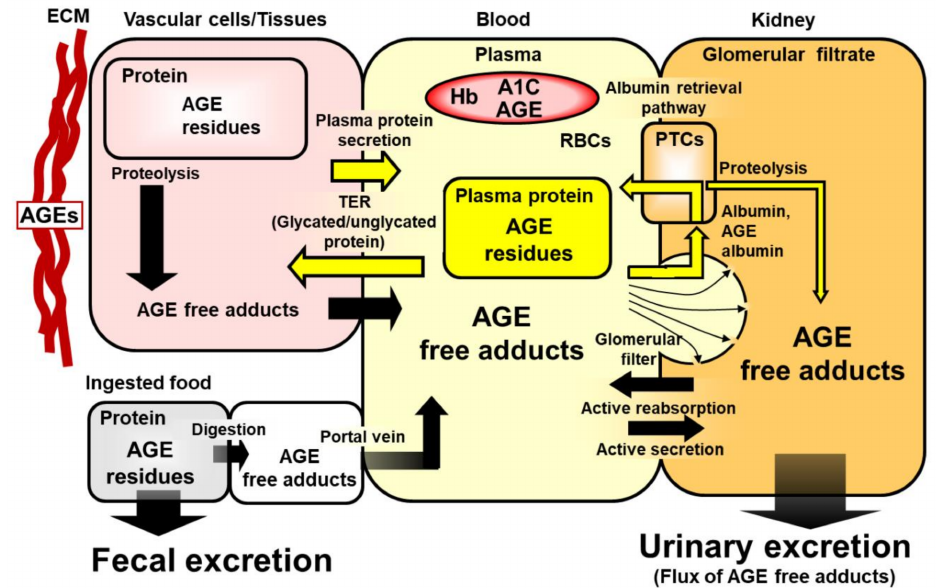
Figure 1. Schematic representation of formation, physiological processing and metabolic transit of protein AGEs in clinical metabolism. Block yellow arrows show movement of plasma protein out of and in to the plasma compartment by TER and tissue secretion, respectively, and glomerular filtration of AGE modified albumin and AGE free adducts with major recovery of albumin into the renal venous circulation by the albumin retrieval pathway and minor degradation by PTC proteolysis.